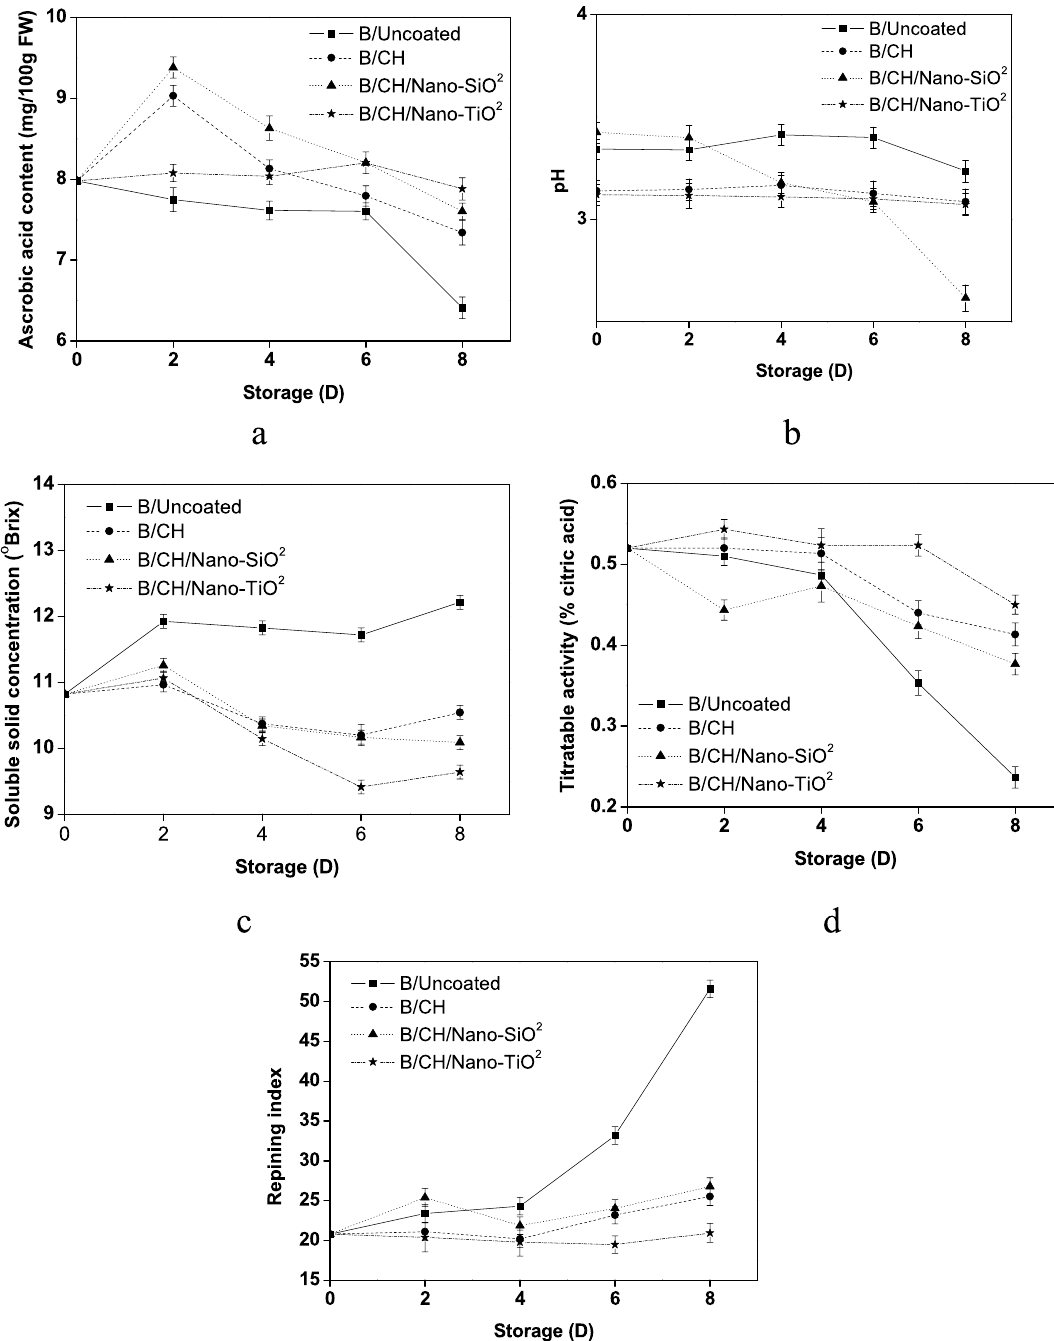
Figure 4. Phytochemical changes of ascorbic acid content ( a ), pH ( b ), soluble solid concentration ( c ), titratable acidity ( d ), and repining index ( e ) for coated blueberry